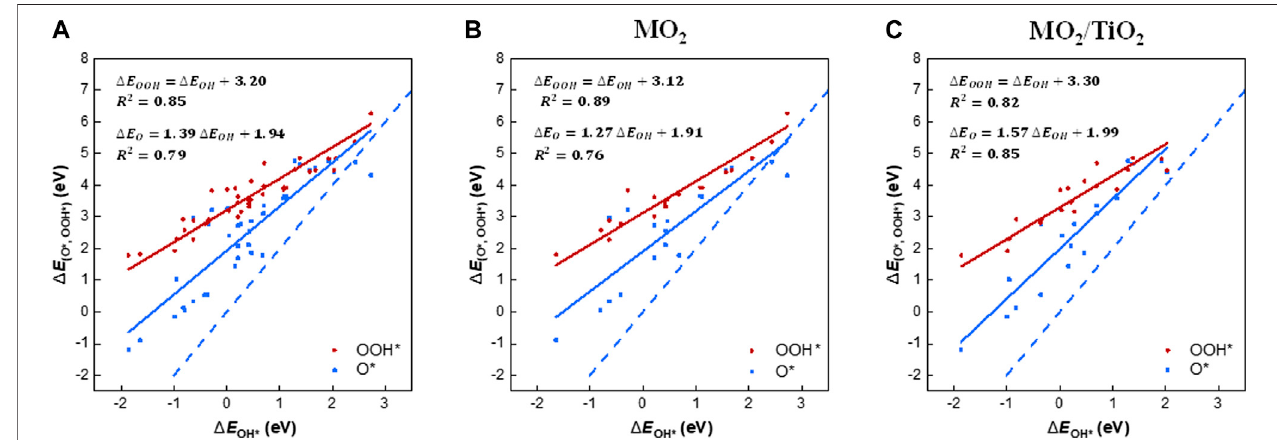
FIGURE 2 | Scaling relations of the binding energies of the OER intermediates (i.e., OH*, O*, and OOH*) with the binding energy of OH*, which is the fi rst intermediate for the OER. The diagrams contain the binding energies on the (110) surface of (A) all rutile-type oxides in this study, (B) MO 2 , and (C) MO 2 /TiO 2 heterostructures, respectively.Thesolidlines arethelineartrendsofthebinding energies ofOOH*(red) andO*(blue)withrespect tothebindingenergy ofOH*.Theblue dashed line in all diagrams is the guideline of the O* intermediate, which indicates the double bonding nature on the surface, with a slope of 2.